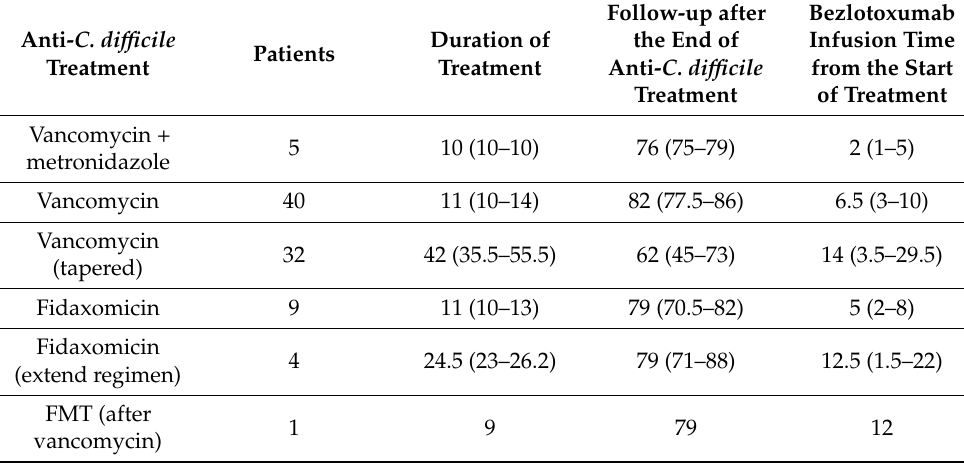
Table 1. Duration of anti- C. difficile drug therapy.